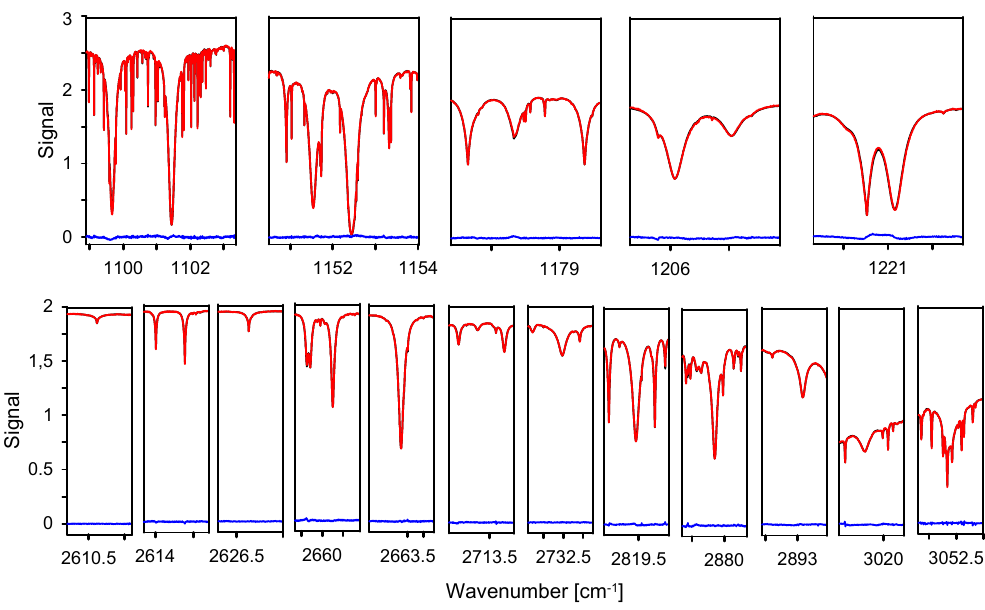
Figure 2. The A-type (above) and M-type (below) spectral microwindows taken from spectra measured on 7 May 2016. Red lines: measured spectra; black lines: simulated spectra; blue lines: residuals (difference between measurement and simulation). IWV content equals 8mm; solar elevation angle is 47.1 ◦